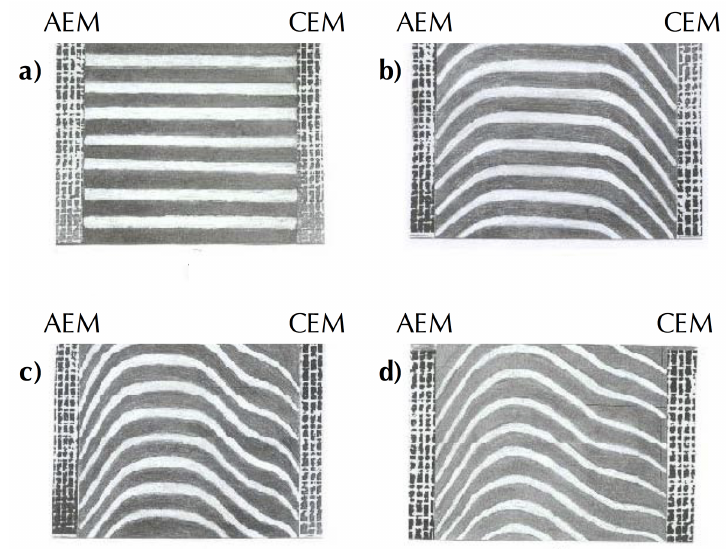
Figure 6. Interferograms of a 1.0 × 10 − 2 mol / L sodium chloride solution in the diluate compartment of an ED cell at di ff erent current densities ( a ) 0 A / m 2 , ( b ) 18.5 A / m 2 , ( c ) 59.7 A / m 2 and ( d ) 126.0 A / m 2 . Experimental conditions: flow rate of 1.26 × 10 − 3 m / s, intermembrane distance of 1.5 × 10 − 3 m, coordinate in the direction of solution feed 1.1 × 10 − 2 m (with permission from Vasil’eva et al. [20]). AEM: Anion-exchange membrane; CEM: Cation-exchange